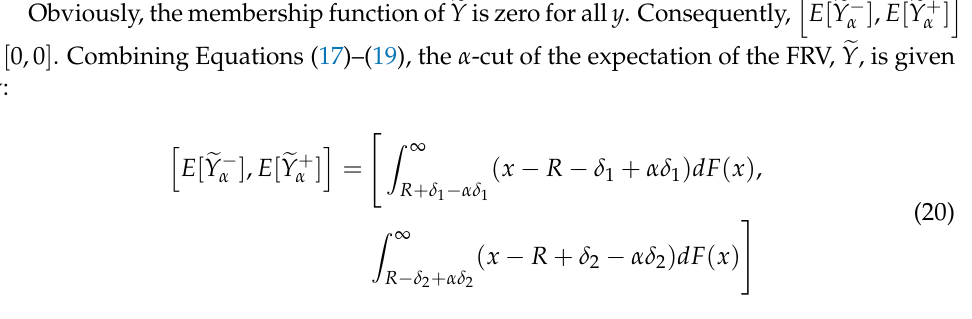
Figure 5. Membership function of the fuzzy shortage quantity when x < R − δ 2